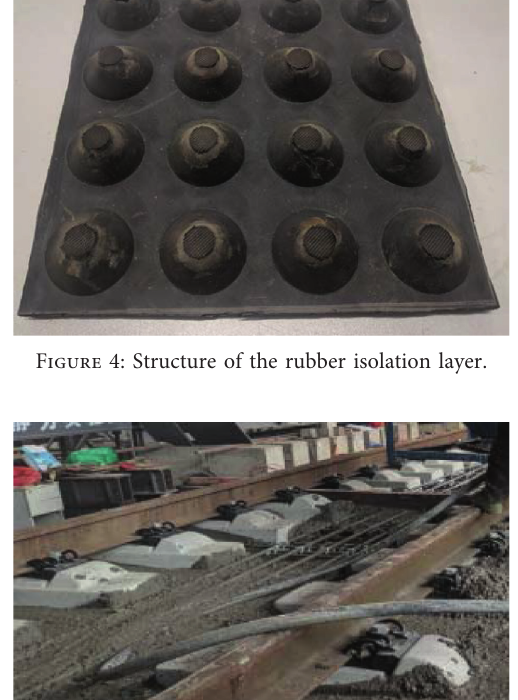
Table 1: Unballasted tracks used in this